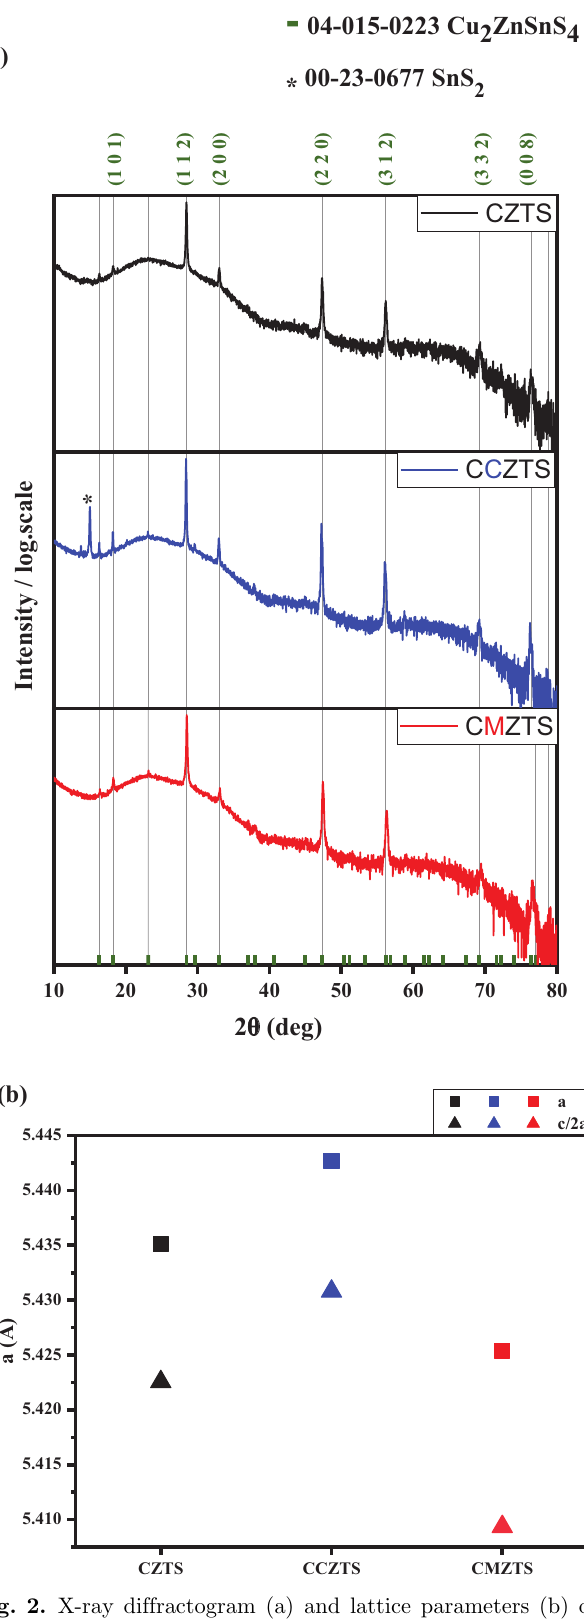
Fig. 2. X-ray diffractogram (a) and lattice parameters (b) of CZTS, CCZTS and CMZTS samples.